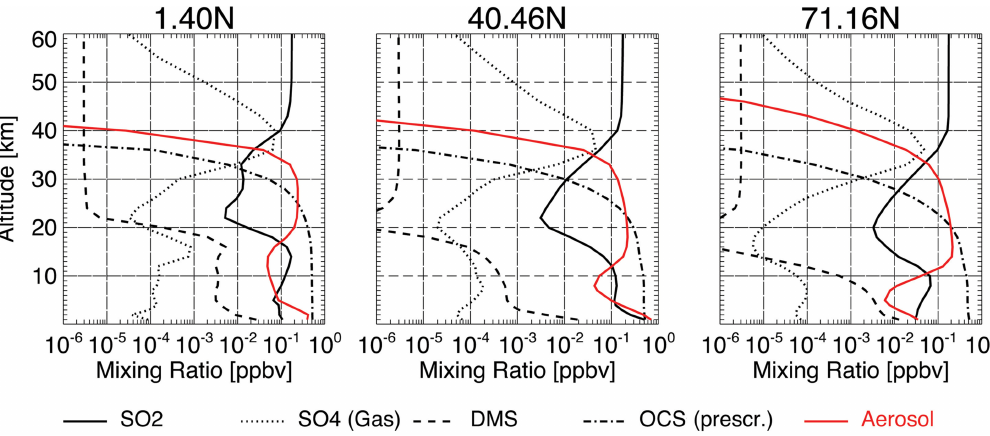
Fig. 2. Calculated vertical profiles of modelled sulphur constituents in the Northern Hemisphere. Shown here are climatological zonal means of the 11yr analysis period from 1996 to